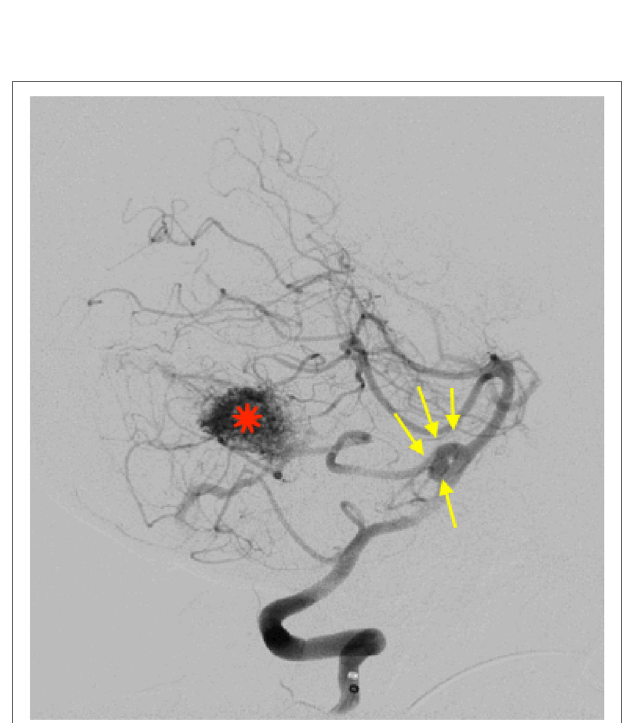
FIguRe 2 | Lateral view of a right vertebral angiography revealing a ruptured proximal aneurysm (7 mm × 3 mm) at the origin of AICA (yellow arrows). Distally on the same trunk, a nidus of an arteriovenous malformation is demonestrated (diameter = 2.6 cm) (red star).